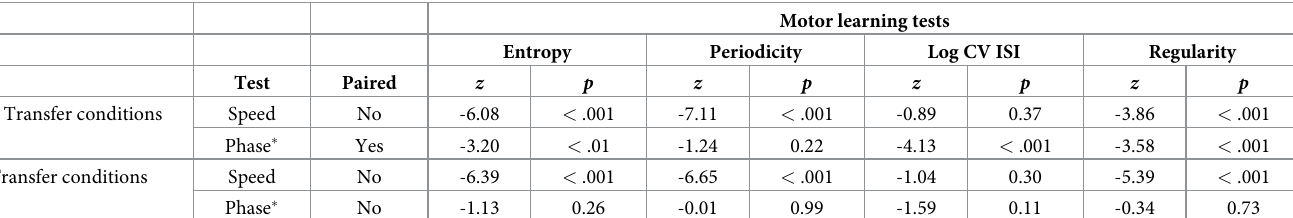
Table 5. Transfer and no transfer comparisons across speeds and